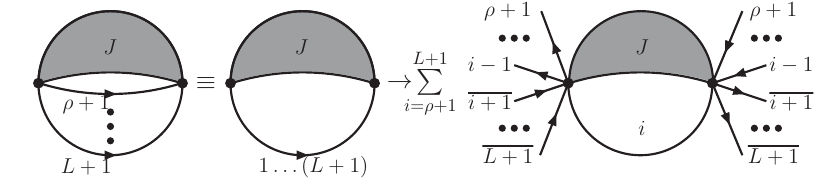
Figure 9 . Graphical factorization of a multi-loop topology with a MLT insertion. The gray blob represents the subtopology with specific topological complexity. The diagram on the r.h.s. of the arrow represents the opening of the MLT